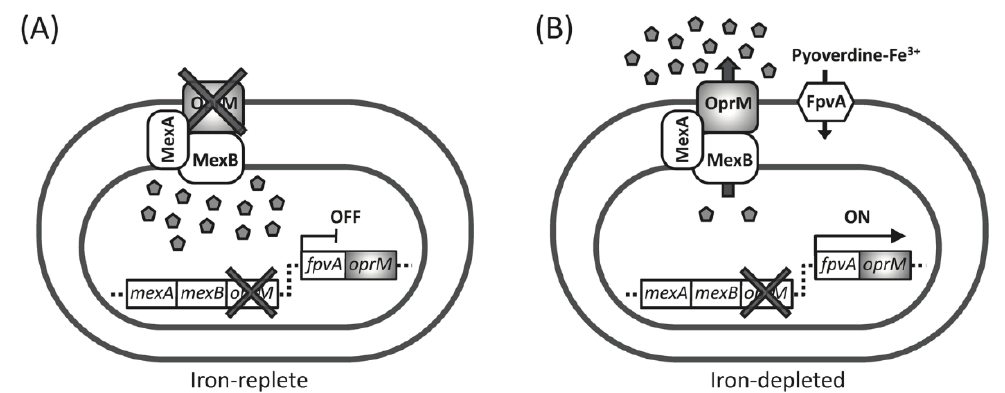
Figure 1. Experimental design of the screening system. The oprM gene is placed immediately downstream site of the fpvA gene of the oprM -deficient cell by homologous recombination. As a result, the reporter strain shows susceptibility and resistance (wild-type susceptibility) to a MexAB-OprM efflux pump substrate antibiotic (pentagons) under iron-replete ( A ) and iron-depleted ( B ) conditions, respectively, since the expression of the oprM gene is under the control of the fpvA gene.